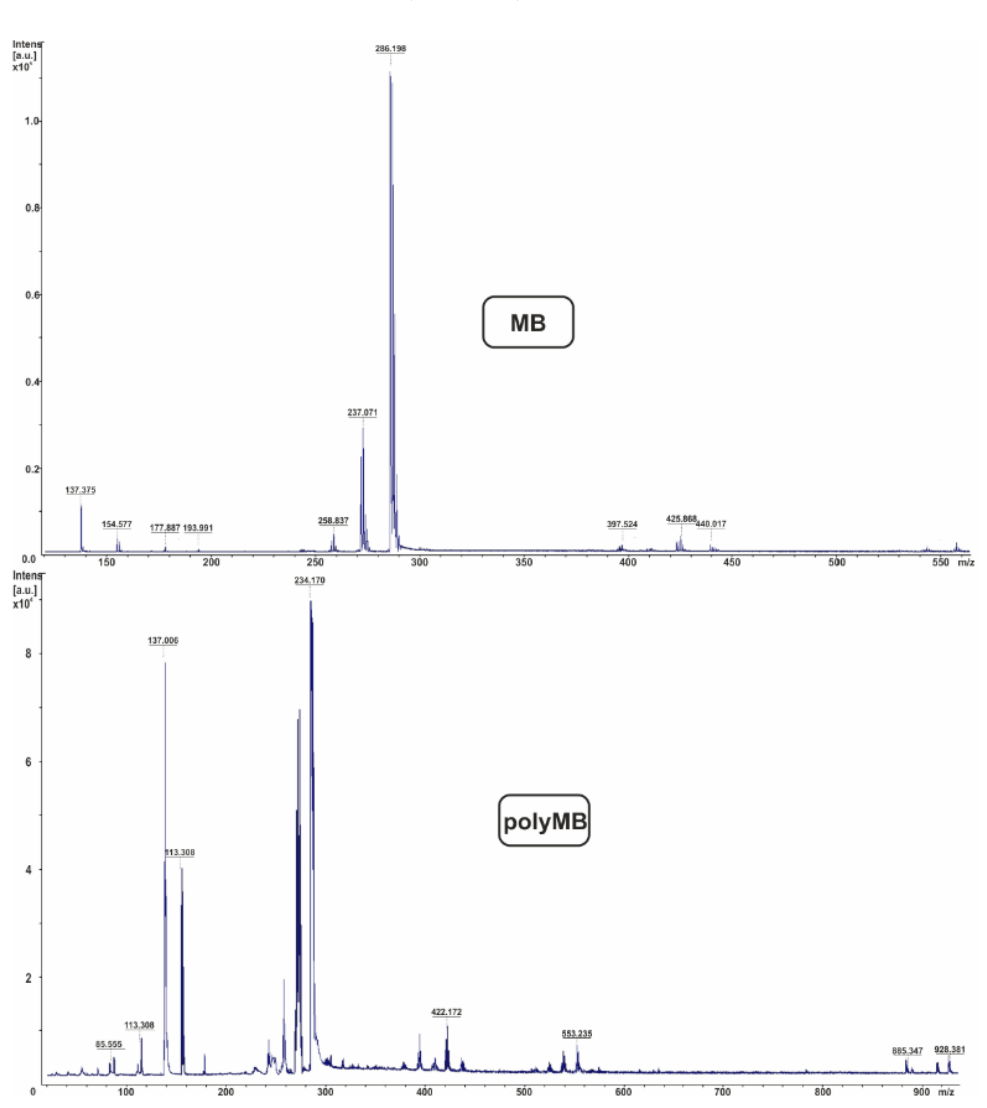
Figure 5. Photos of samples: ( A )—methylene blue; ( B )—polymethylene blue.